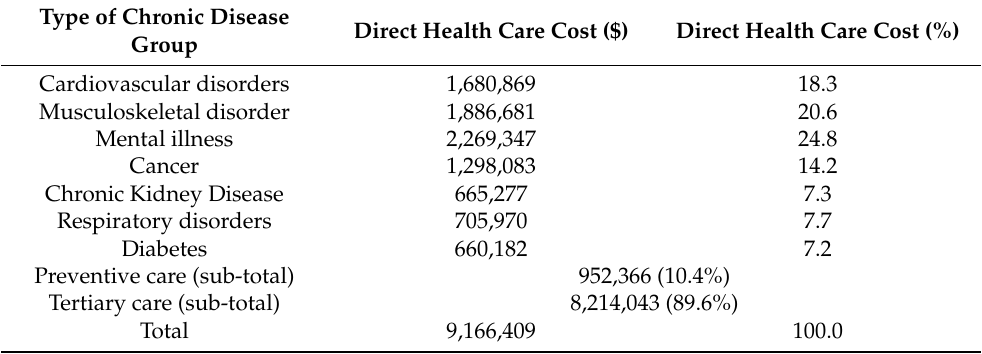
Table 2. Total extra direct health care costs incurred due to LHL by type of chronic disease group in the Blacktown LGA (Domain 6).